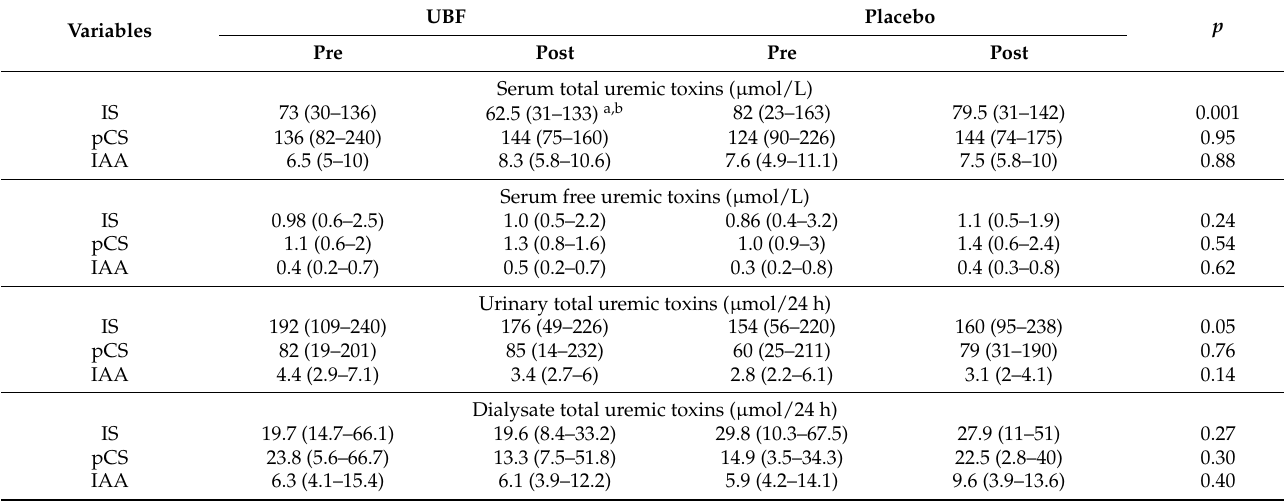
urinary and dialysate excretion of uremic toxins did not differ between the arms during the follow-up (Table 4). Table 4. Uremic toxins in adherent patients according to UBF and placebo arms during the follow-up of patients undergoing peritoneal dialysis ( n = 11).